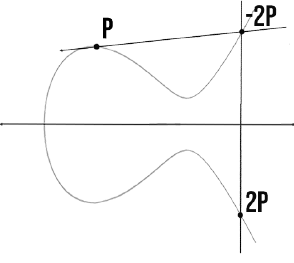
Figure 4. Point doubling on